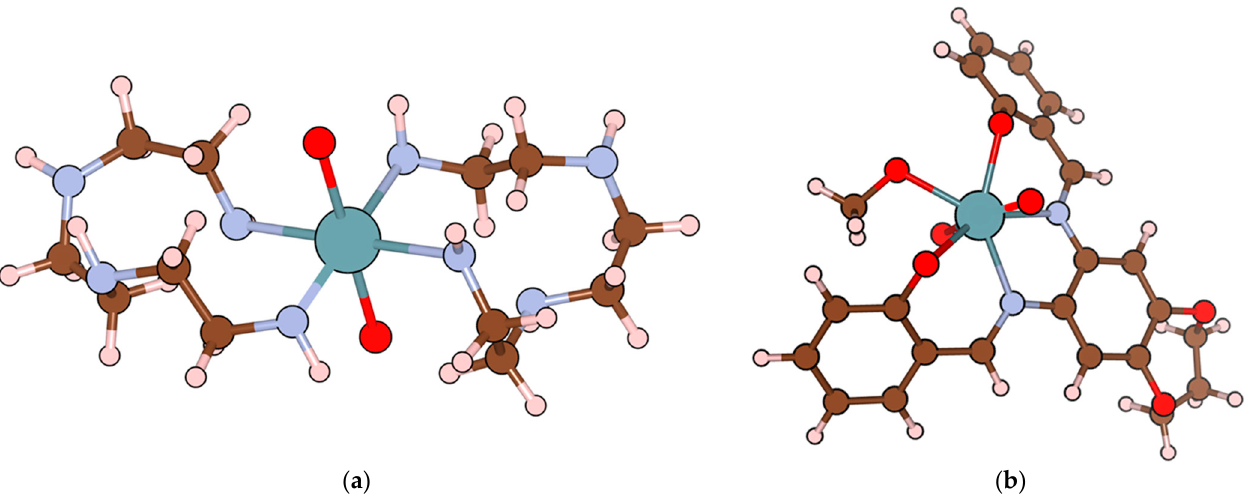
Figure 8. Chemical structure of the ( a ) uranyl-TETA complex and ( b ) uranyl- N,N’-(propylenedioxy)benzenebis(salicylideneimine) complex.